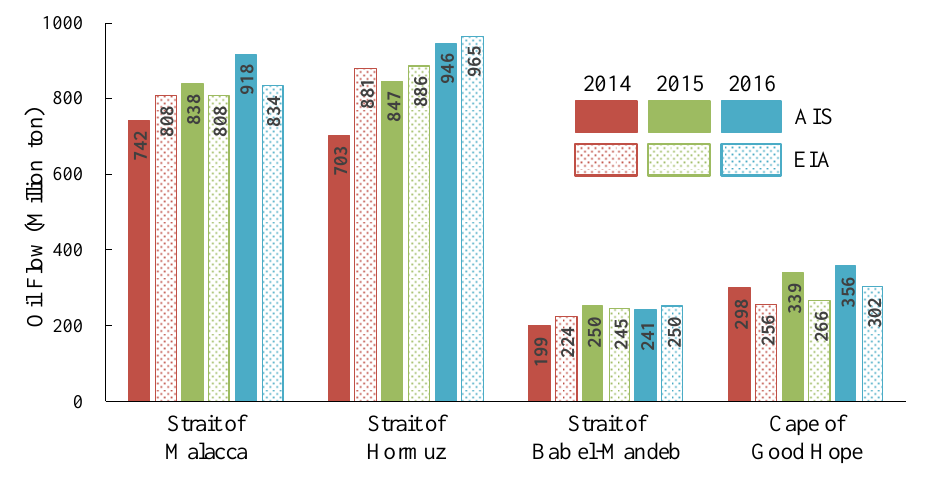
Figure 5. Discrimination of the oil tanker load condition. ( a ) The variation of the oil tanker draft over time; ( b ) The frequency distribution map of the oil tanker draft; ( c ) The clustering result of the oil tanker draft.